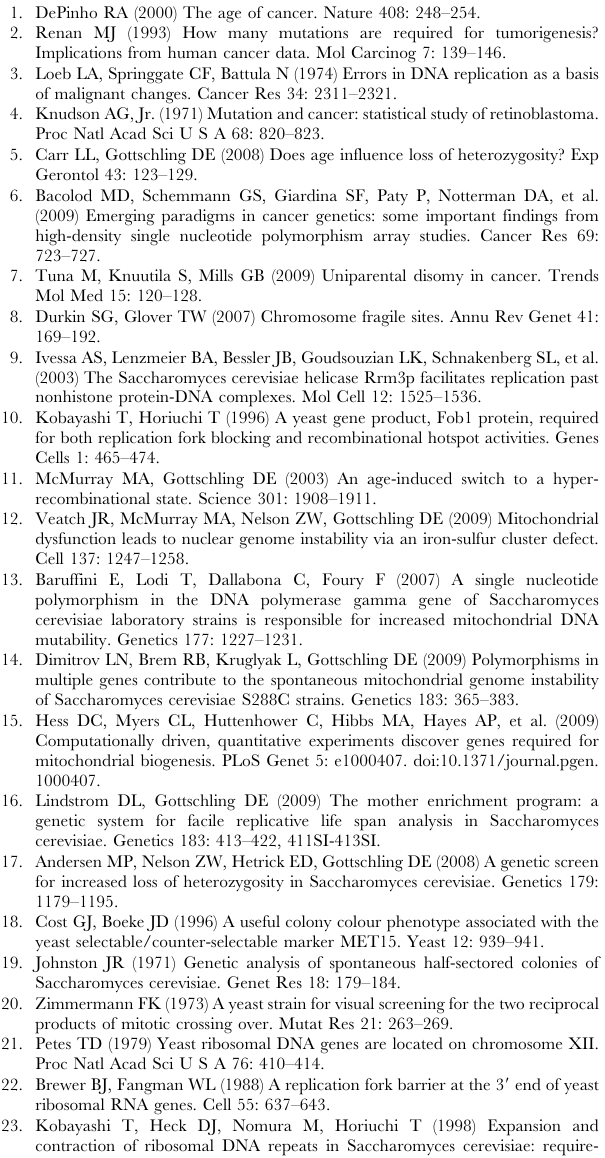
Table S2 Oligonucleotides used in this study.